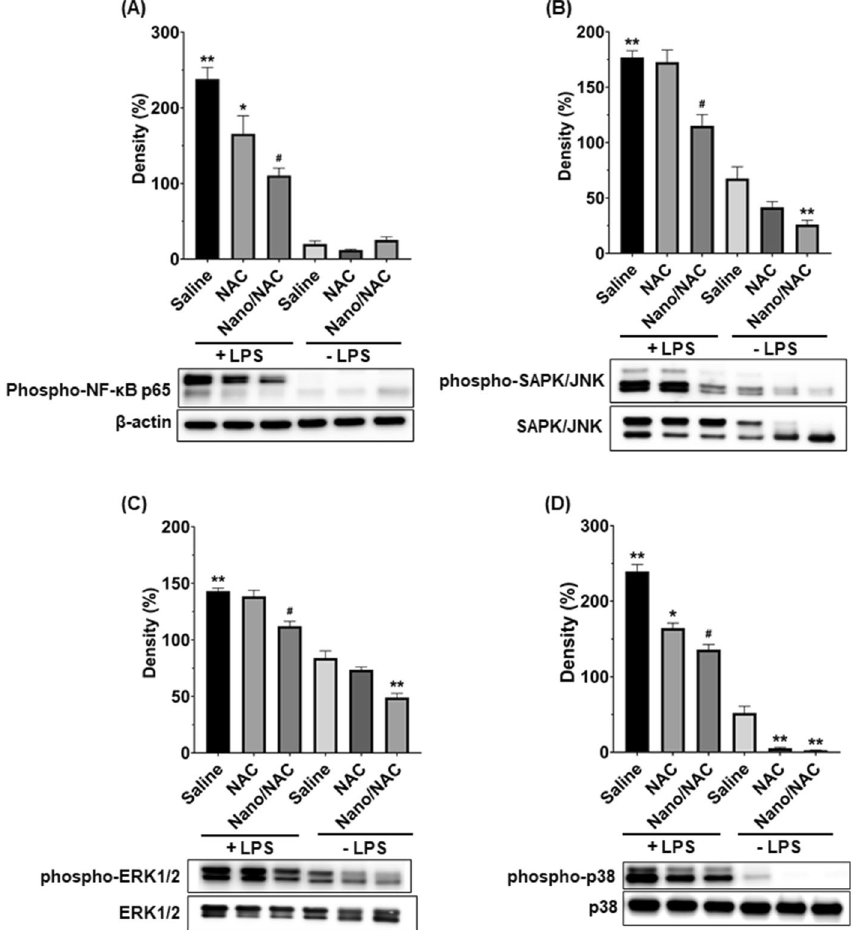
Figure 8. Effects of Nano/NAC on activation of the NF-kB and MAPK pathways in lung tissues, as determined by western blot analysis. Expression of β-actin, SAPK/JNK, ERK1/2, and p38 was used as a loading control. ( A ) LPS treatment elicited a significant increase in the level of phospho-NF-κB p65. NAC or Nano/NAC treatment significantly reduced the level of phospho-NF-κB p65, with a greater significant difference observed after Nano/NAC co-treatment. ( B – D ) Significant increases in the phospho-SAPK/JNK, phospho-ERK1/2, and phospho-p38 levels were observed in the LPS group. NAC treatment significantly suppressed the levels of phospho-p38, but not those of phospho-SAPK/JNK and phopho-ERK1/2. However, Nano/NAC treatment significantly suppressed the levels of phospho-SAPK/JNK, phospho-ERK1/2, and phospho-p38. The